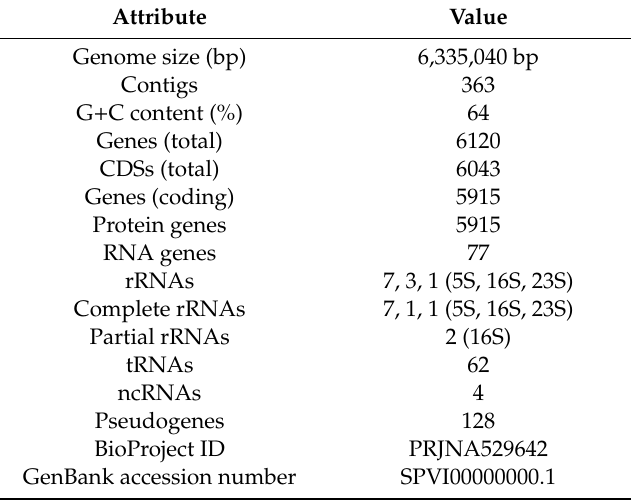
Table 4. General genome features of P. fluorescens